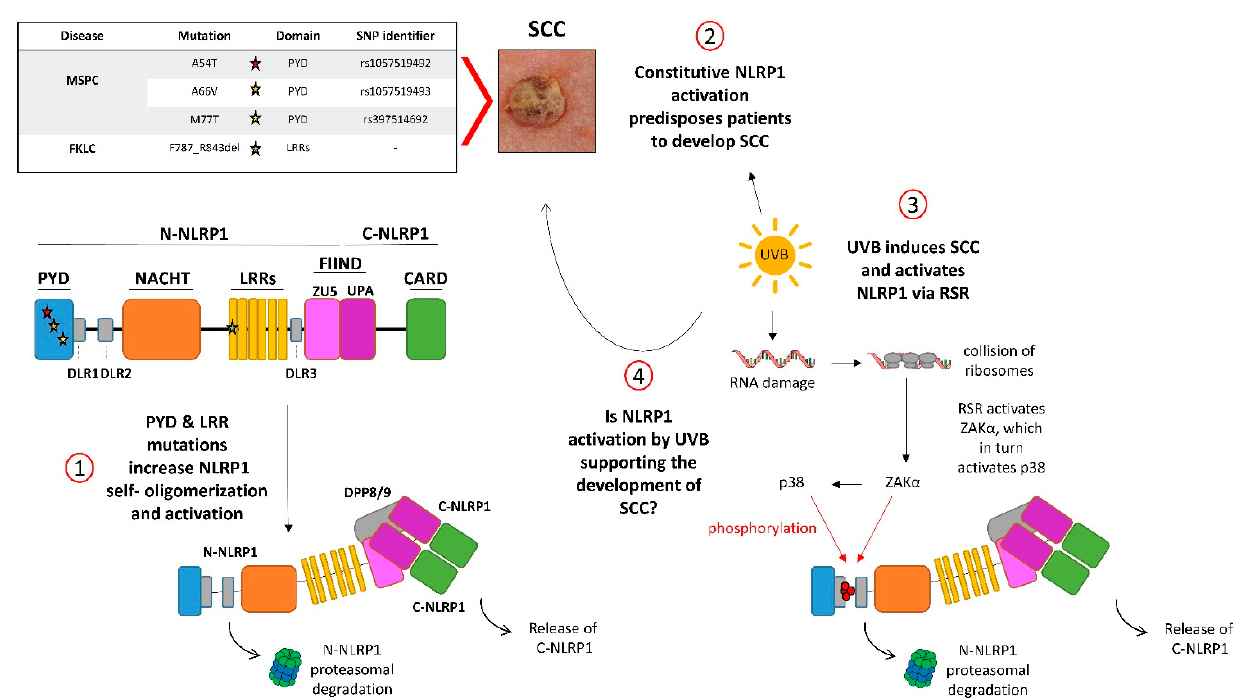
Figure 2. NLRP1, UVB, and skin cancer. (1) NLRP1 is a five-domain self-processing protein. Self-processing occurs in the FIIND (function-to-find domain) between the ZU5 and UPA subdomains, generating the inhibitory N-NLRP1 and the effector C-NLRP1. Germline gain-of-function mutations of NLRP1 (stars) cause the inflammatory skin syndromes MSPC (multiple self-healing palmoplantar carcinoma) and FKLC (familial keratosis lichenoides chronica), predisposing patients to develop SCCs (2). These mutations induce self-oligomerization and -activation of NLRP1 by release from C-NLRP1 from the dipeptidyl peptidases DPP8/9 and the inhibitory N-NLPR1 (1). (3) The UVB spectrum of the sunlight activates NLRP1 via the ribotoxic stress response (RSR) upon sensing of collision of ribosomes by the kinase ZAK α . Then, ZAK α phosphorylates and activates the stress-induced kinase p38, and both enzymes phosphorylate N-NLRP1 in DLR1 (disordered linker region 1), causing its proteasomal degradation and release of C-NLRP1. (4) It is tempting to speculate that NLRP1 activation either by UVB or by MSPC-causing mutations induces the development of SCCs by overlapping